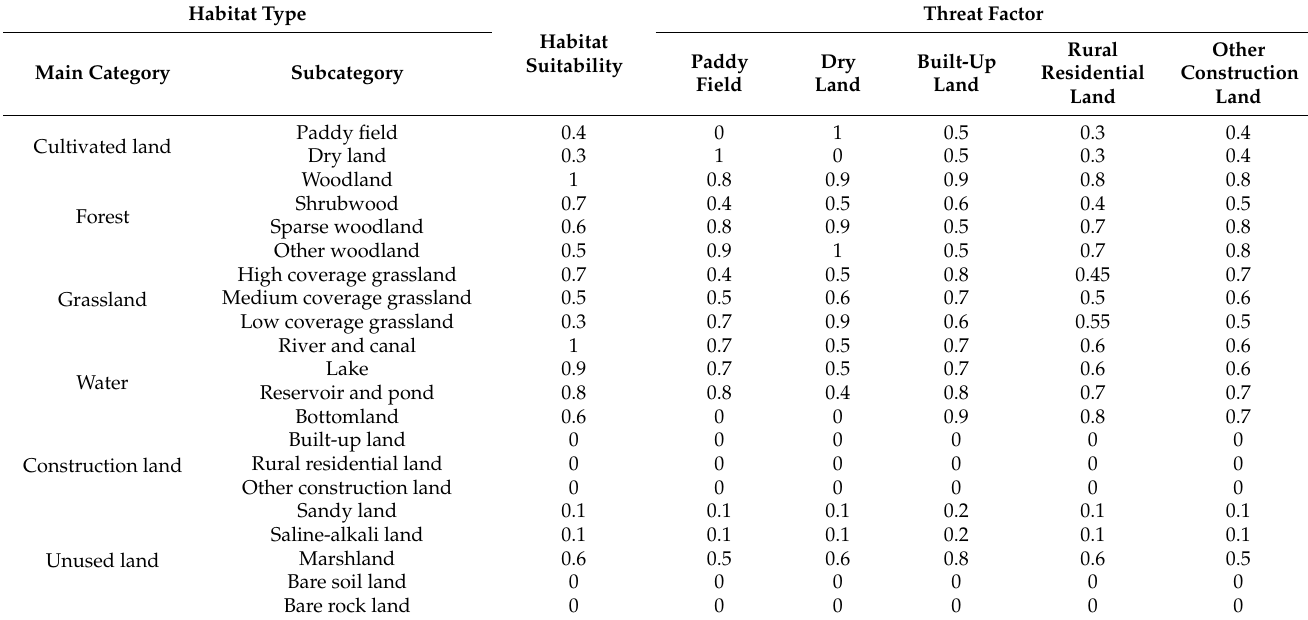
Table 1. Habitat types and sensitivity of habitat types to each threat.